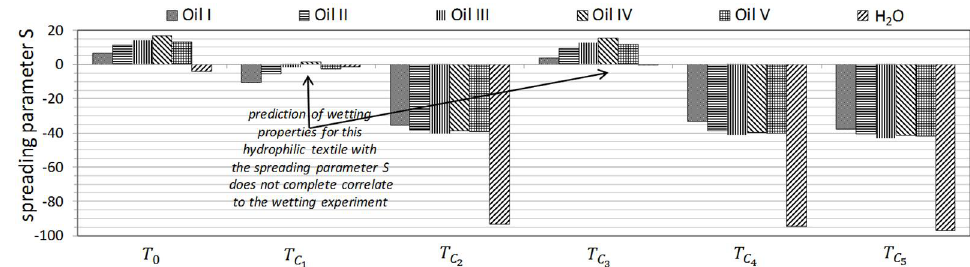
Figure 8. Spreading parameter S between textiles and functional fluids.